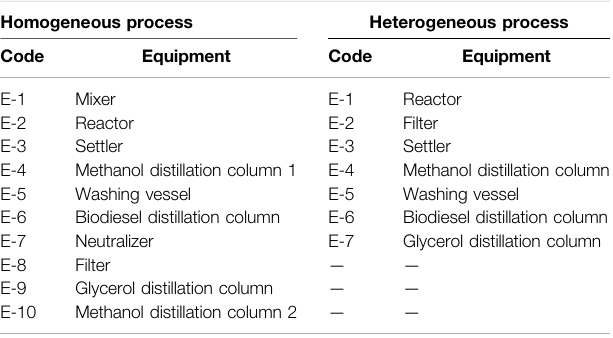
TABLE 1 | Summary of process equipment used in the homogenous and heterogeneous processes. Homogeneous